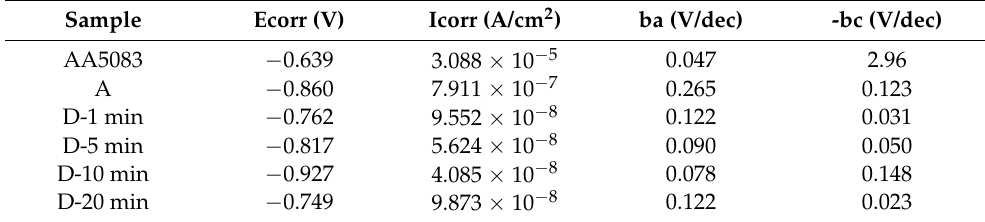
Table 5. Data gained from the polarization curves of coated and uncoated AA5083 samples in 3.5 wt.% NaCl corrosive media. The samples were prepared by the D Pretreatment Method with the different deposition times of (1, 5, 10, and 20